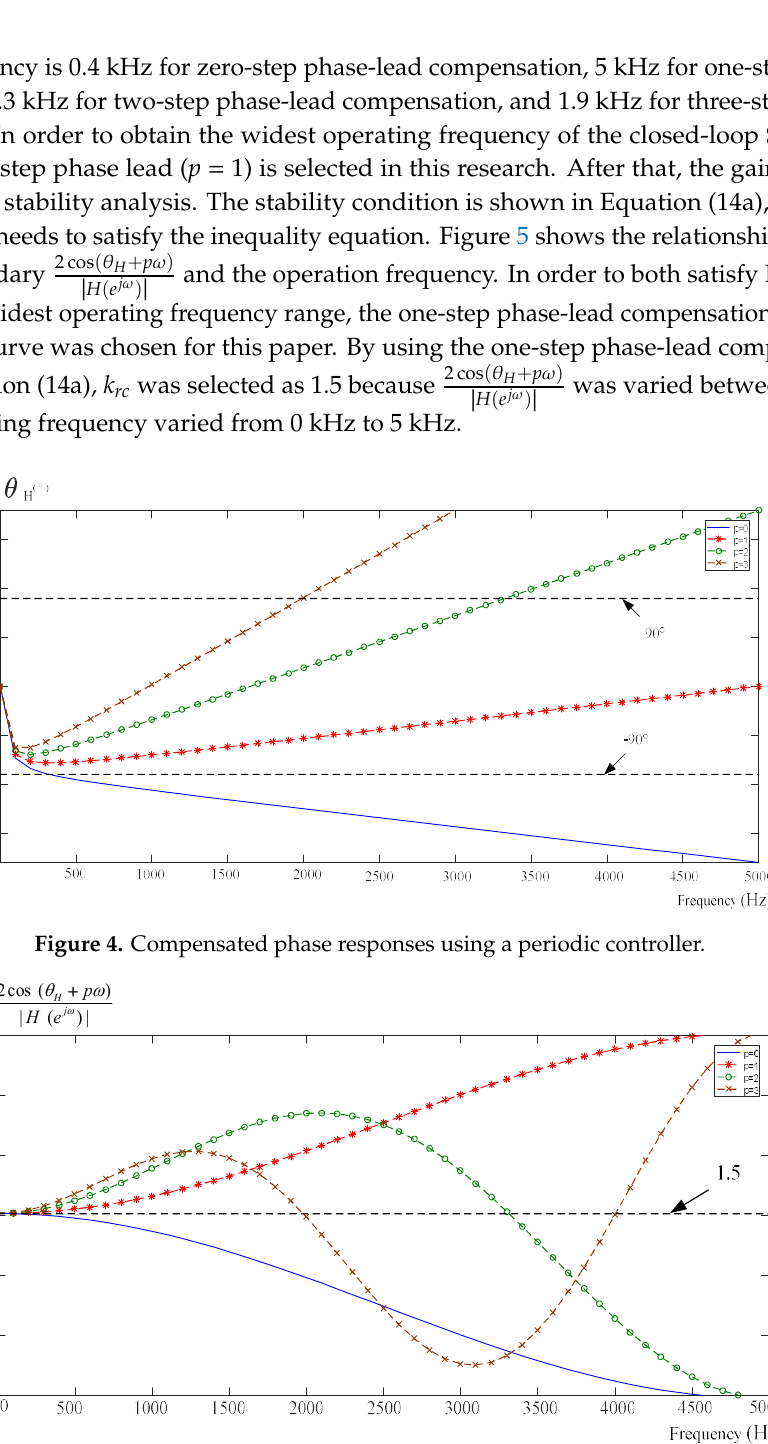
Figure 5. Boundary of control gain under different compensated phases.